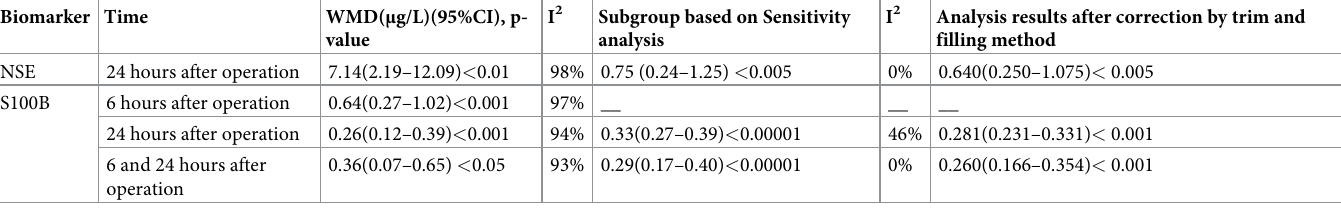
Table 3. Summary of meta-analysis